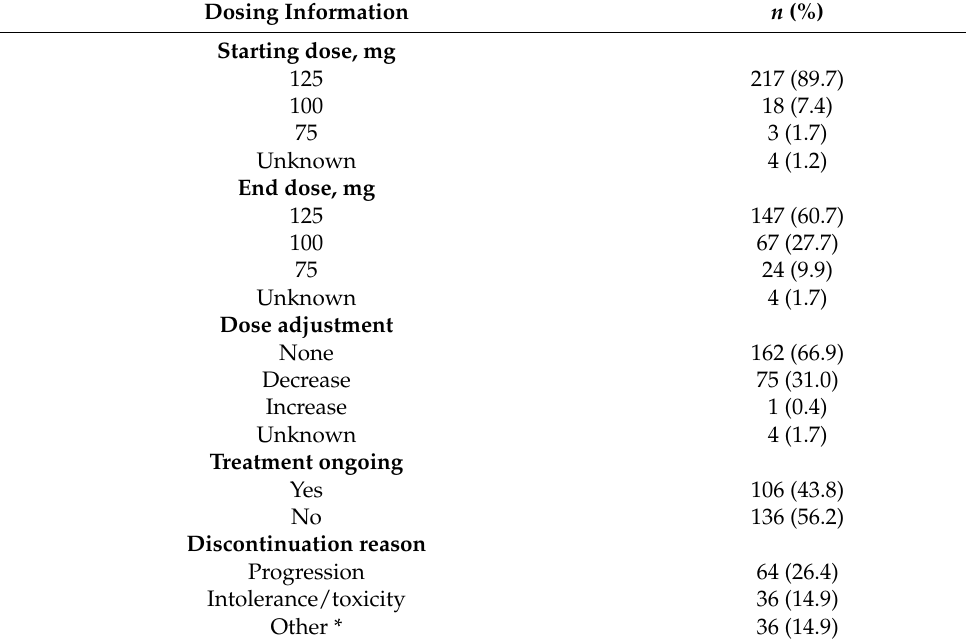
Table 3. Palbociclib dosing information ( n = 242).